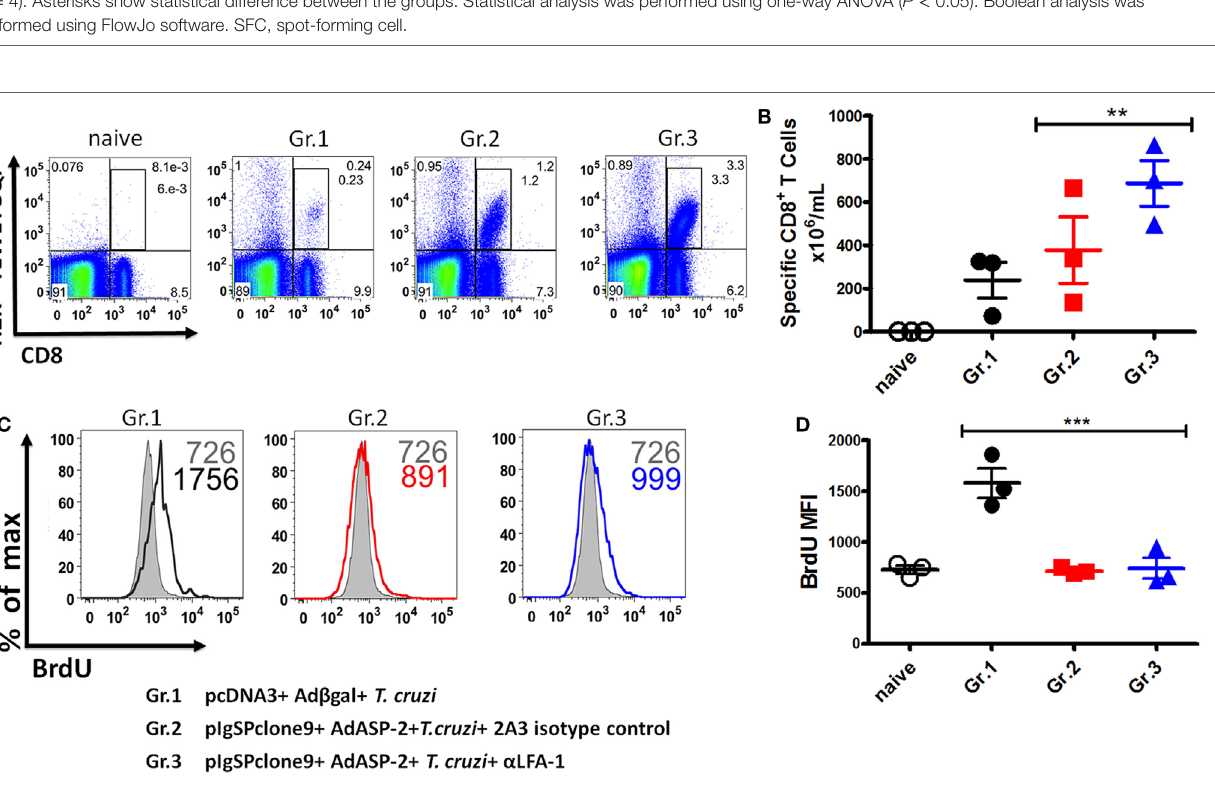
FigUre 6 | Specific CD8 + T cells can proliferate after the treatment with anti-LFA-1. A/Sn mice were immunized with ASP-2 using the heterologous “prime-boost” vaccination regimen, infected with 150 trypomastigotes forms of Trypanosoma cruzi , and treated with anti-LFA-1 or isotype control until 20th days after infection. Mice received 2 mg of 5-bromo-2 ′ -deoxyuridine (BrdU) every 48 h. In this day, spleen was harvested for the proliferation assay. 2 × 10 6 splenocytes were labeled with H2K K -TEWETGQI multimer, anti-CD8 and anti-BrdU. (a,B) The frequency and absolute number of specific CD8 + T cells in the spleen, respectively.